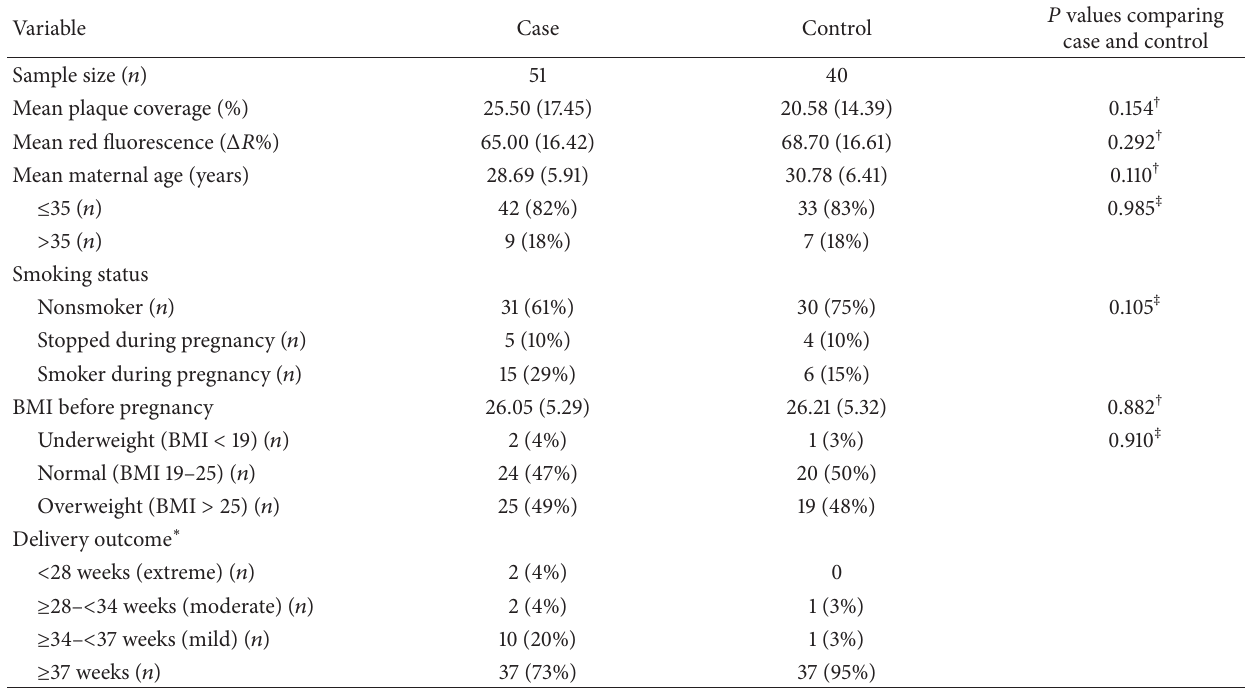
Table 1: Summary of red fluorescence and plaque coverage data of the anterior teeth ( 𝑛 = 10–12 per individual) with other logistic regression model parameters (figures in parentheses are standard deviations unless identified as percentages).